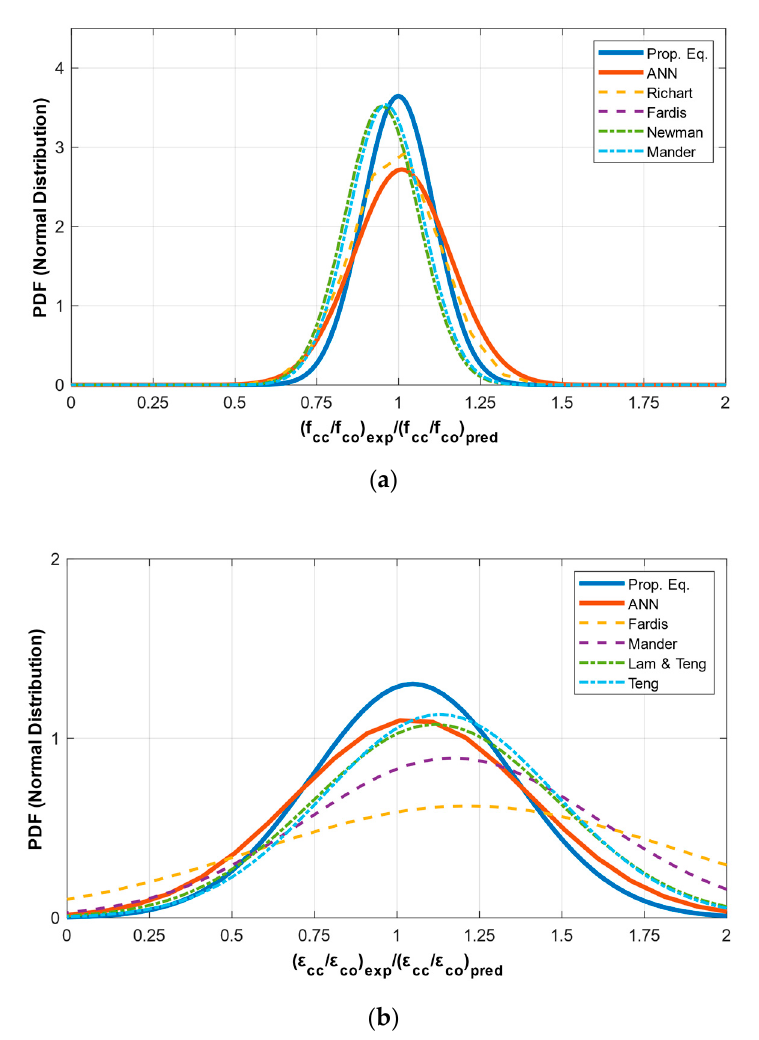
Figure 11. Probability density functions (as normal distributions) for the various prediction models: ( a ) strength; ( b ) strain.